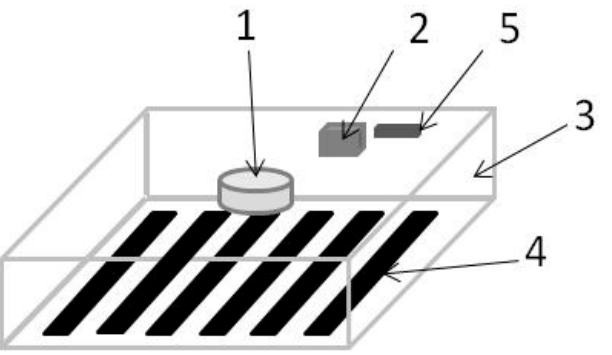
Figure 5. Schematics of the active device: 1. camera, 2. processing unit, 3. cover box, 4. applied image, 5. control